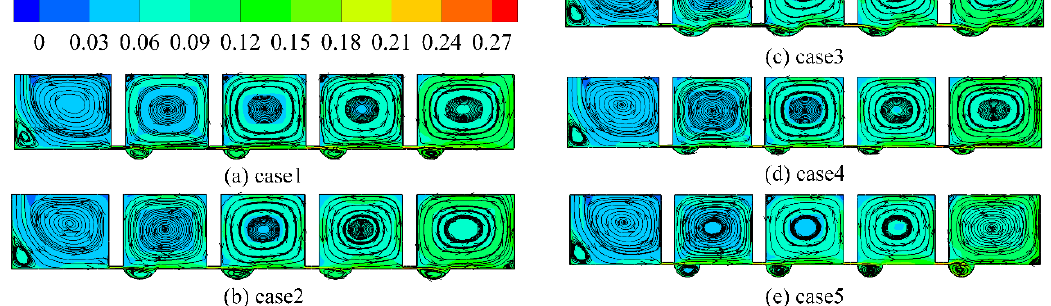
Figure 16. The Mach number contours of meridional plane of leakage passage on stator1 of case1 – 5.